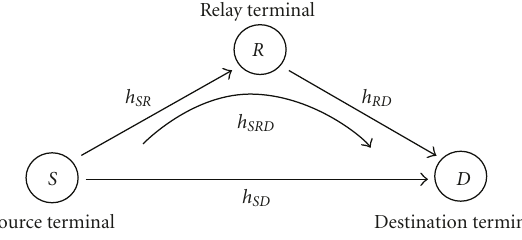
Figure 1: A simple cooperative communication